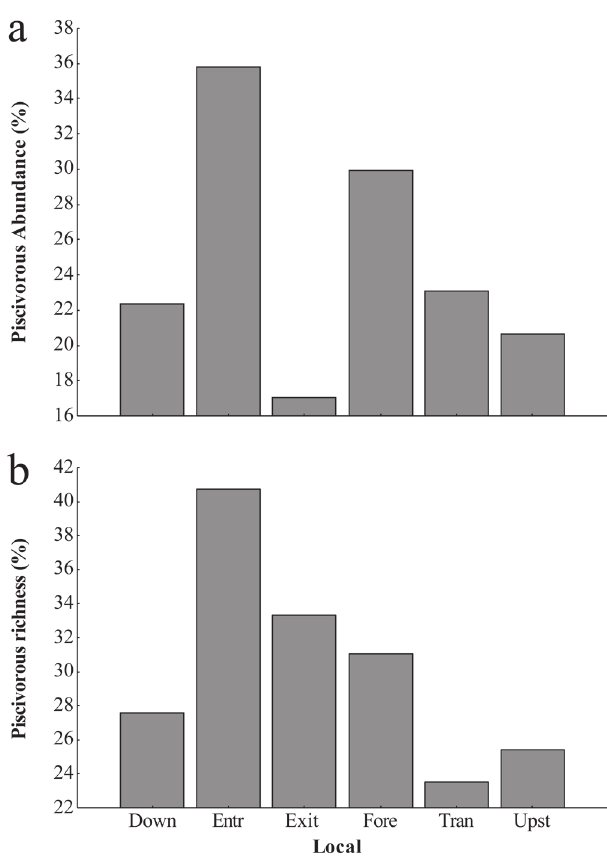
Fig. 2. Abundance ( a ) and species richness ( b ) of piscivorous fish in the Lajeado Dam fish ladder (Entr = entrance and exit), and adjacent to the dam (Down = downstream, Fore = forebay, Tran = reservoir transition, and Upst =